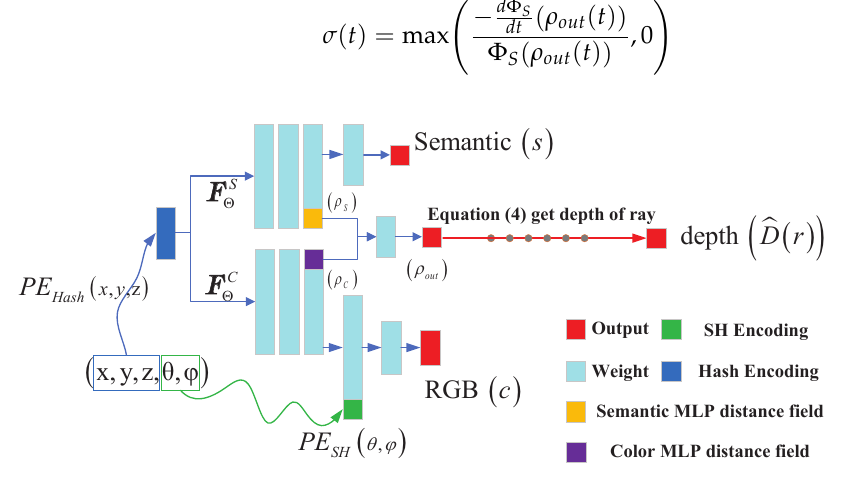
Figure 6. Inspection-Nerf